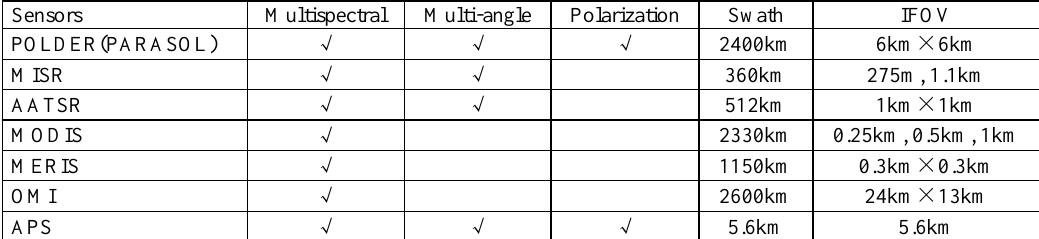
Table 1. Major characteristics of aerosol measuring